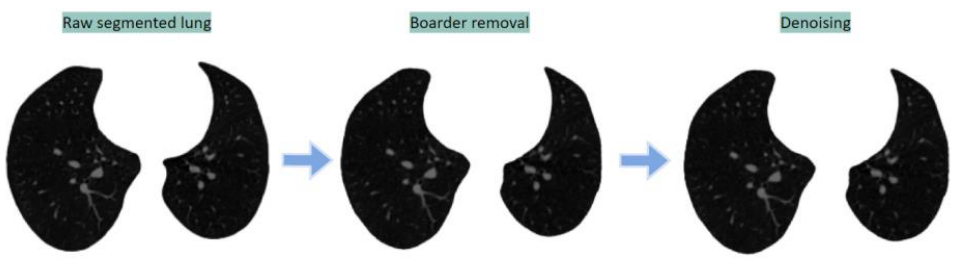
Figure 19. Preprocessing of segmented lung images.